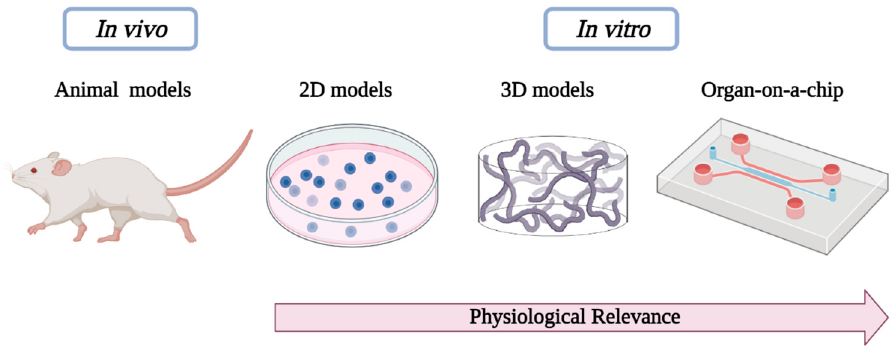
Figure 1. Schematic diagram showing the preclinical models used in biomedical research.